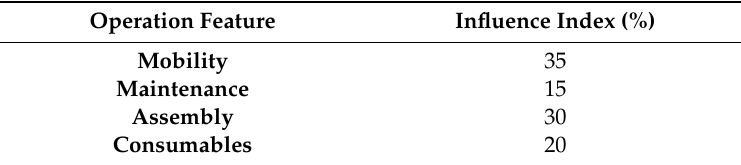
Table 5. Value of the influence index of the operation